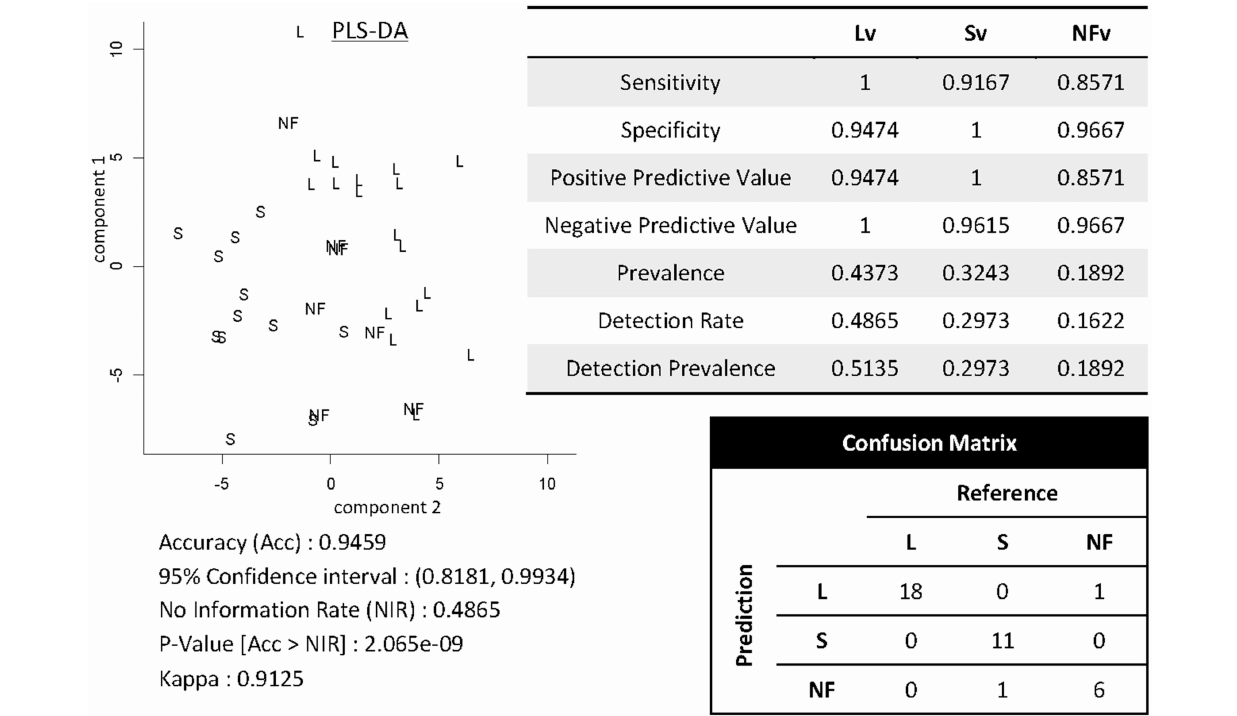
FIGURE 12 | Showing partial least squares—discriminant analysis (PLS-DA) for classifying 37 individuals into PPA variants based on volumetric data of 120 parcellated